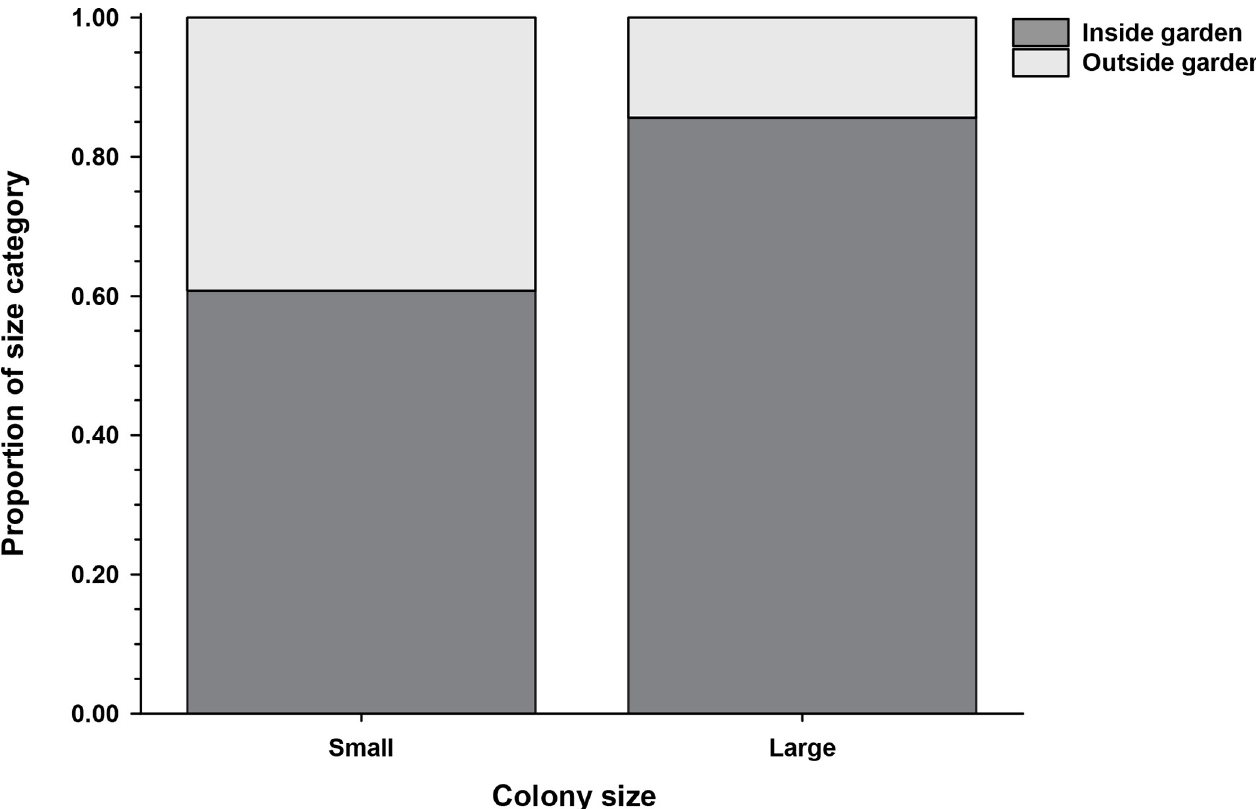
Fig 1. Proportion of small and of large Pocillopora as a function of farmerfish garden status. The proportion of small ( � 10 cm dia) and of large ( > 10 cm) Pocillopora colonies encountered inside and outside of farmerfish gardens of the 1,137 colonies surveyed on 178 bommies (small: N = 484 inside, 312 outside; large: N = 292 inside, 49 outside). The proportion of the two size classes inside vs outside of gardens was significantly different ( p < 0.001).